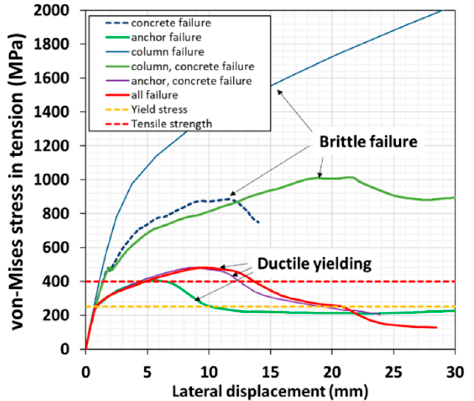
Figure 10. Pushover simulations. Maximum anchor von-Mises stress vs. lateral displacement curve for different failure scenarios involving a cracked concrete bed.